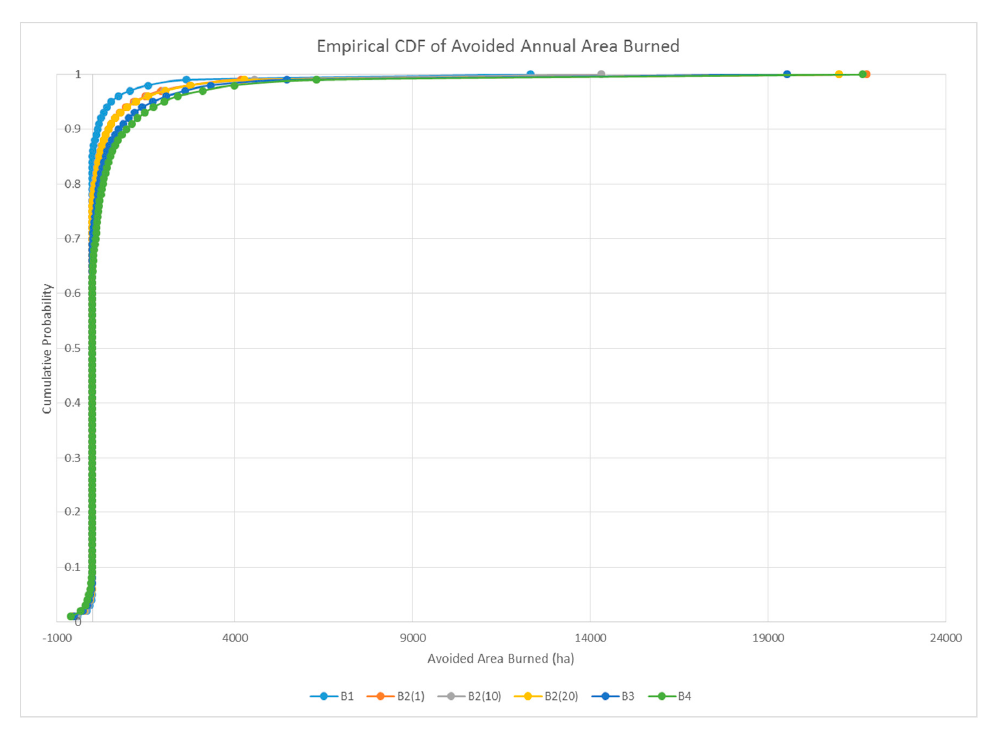
Figure 9. Empirical cumulative distribution function (CDF) for avoided annual area burned. Table 3. Avoided annual area burned summary.